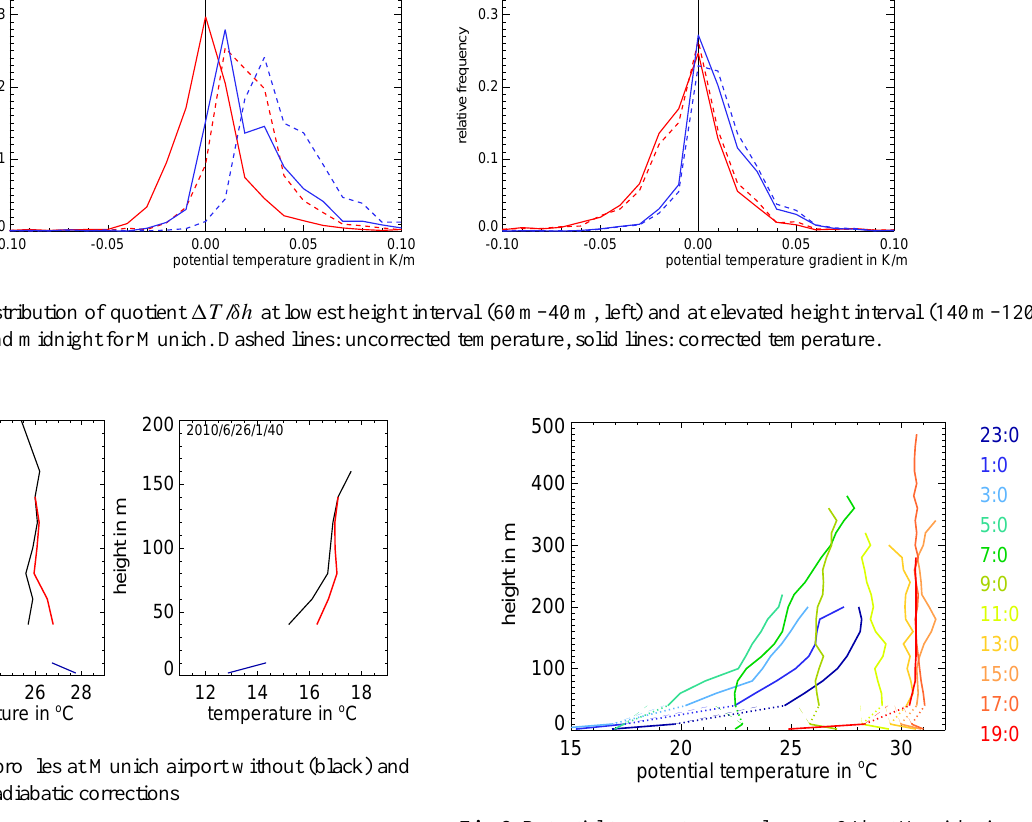
Fig. 8. Potential temperature profiles over 24h at Munich airport on 2/3 July 2010. Figure8:Potentialtemperaturepro(cid:28)lesover24hatMuni hairporton2/3July2010.